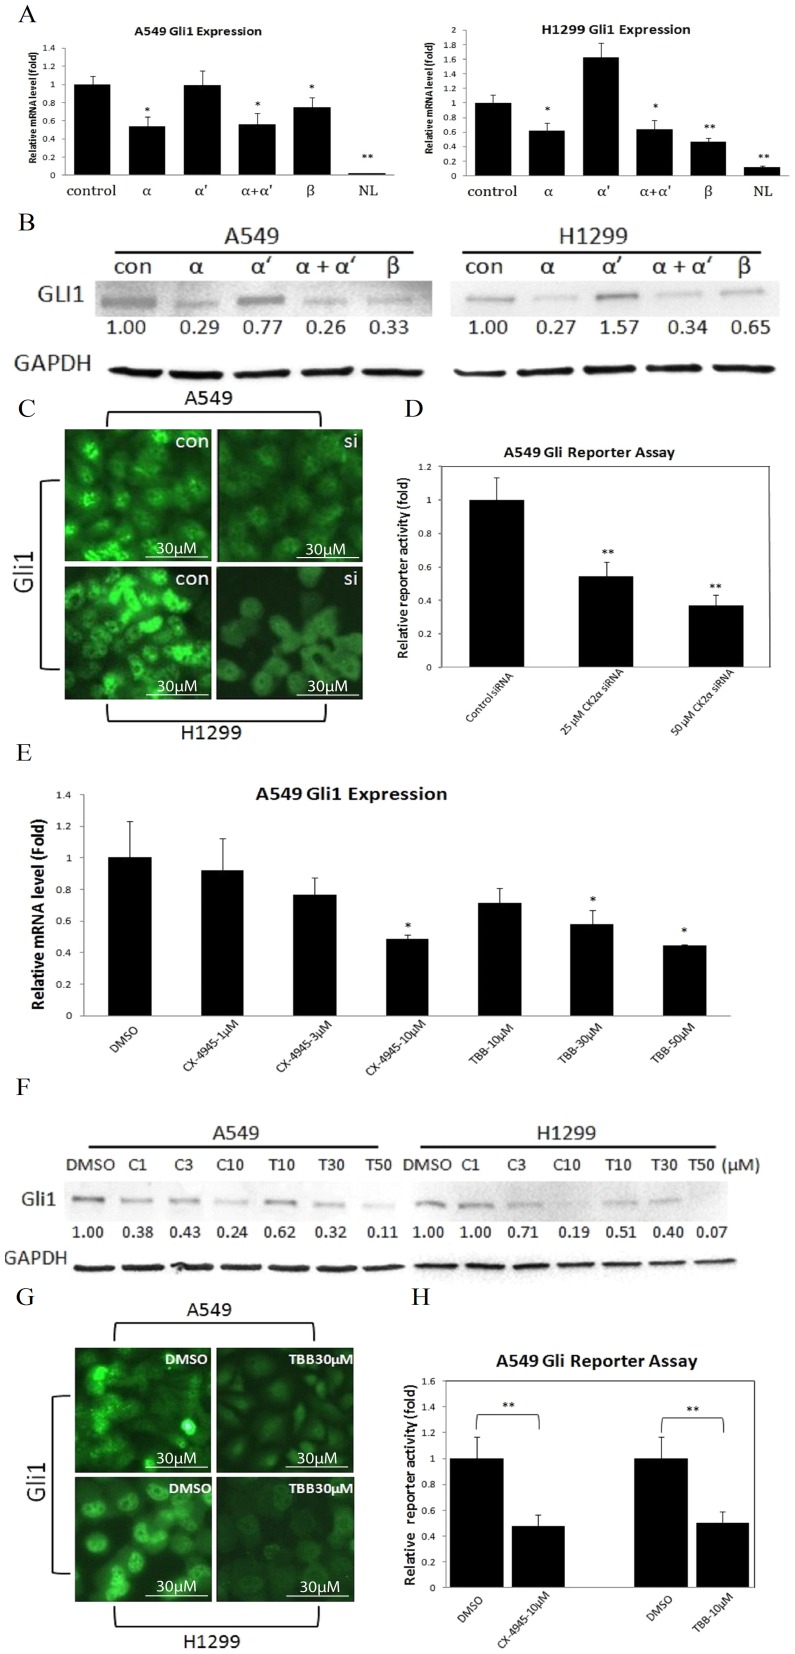
CK2α Inhibition Down-Regulates Gli1 Expression and Transcriptional Activity.(A) Quantitative Gli1 mRNA levels after treatment with CK2 subunit-specific siRNA detected by real-time RT-PCR. Silencing of CK2α significantly reduced Gli1 mRNA levels both in A549 and H1299 cell lines (by 50% and 45%, respectively). Silencing of CK2β also resulted in a significant decrease of Gli1 in both cell lines. Minimal Gli1 mRNA level was noticed in the normal lung (NL). * P<0.05, ** P<0.01, Student’s t-test. (B) Protein levels detected by Western blot. Silencing of CK2α led to 71% (A549) and 73% (H1299) reduction of Gli1, while silencing of CK2β led to 67% (A549) and 35% (H1299) decrease of Gli1. Treatment by CK2α’-targeting siRNA produced no obvious difference, rather than decrease of Gli1 in A549, and produced a 60% increase in H1299, both in mRNA and protein levels. (C) Localization of Gli1 detected by green fluorescence. The Gli1 protein mainly localizes in the nuclear compartment of the cells, and shows a great reduction after CK2α knockdown. Scale bar = 30 µm. (D) The transcriptional activity of Hh pathway in A549 detected by Gli reporter assay. Silencing of CK2α resulted in a significant decrease (more than 40% at 25 µM and 60% at 50 µM) of the transcriptional activity, compared with the control siRNA. * P<0.05, ** P<0.01, Student’s t-test. (E) Quantitative Gli1 mRNA levels after treatment with TBB and CX-4945 by real-time RT-PCR. Gli1 expression in A549 decreased noticeably at the dosage levels of 1 µM CX-4945 and 10 µM TBB, significantly at 10 µM CX-4945 and 50 µM TBB (50% and 60%). * P<0.05, ** P<0.01, Student’s t-test. (F) Protein levels detected by Western blot. In protein level, these decreases rose to 76% (10 µM CX-4945) and 89% (50 µM TBB) in A549, and 81% (10 µM CX-4945) and 93% (50 µM TBB) in H1299, respectively. (G) Protein expression of Gli1 detected by green fluorescence. Cells were treat with 30 µM TBB or vehicle DMSO, immunoflorescence staining with anti-Gli1 mAb on cultured cells showed a distinctly lower green florescence in the presence of 30 µM TBB. (Scale bar = 30 µm). (H) The transcriptional activity of Hh pathway in A549 detected by Gli reporter assay. A 50% decrease was detected in the presence of 10 µM CX-4945 or 10 µM TBB. * P<0.05, ** P<0.01, Student’s t-test.